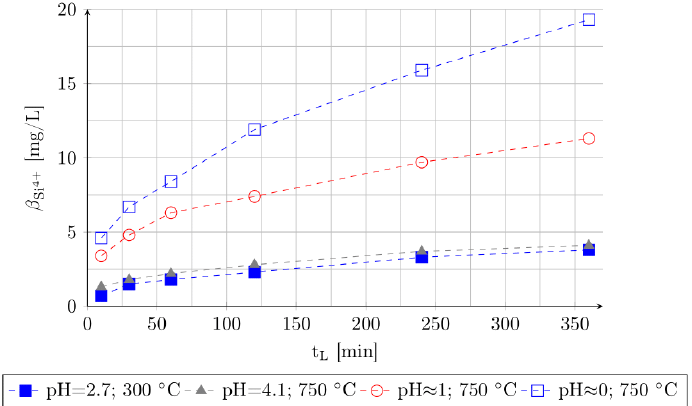
Figure 10. Effect on roasting temperature and pH value of leaching solution on the SiO 2 stability present in the calcine ( n / m conc. = 15 mmol / g; t G = 2 h; ρ PD,L = 25 kg / m 3 ; T L = 20 ◦ C; t L = 24 h; r R,L = 300 rpm).